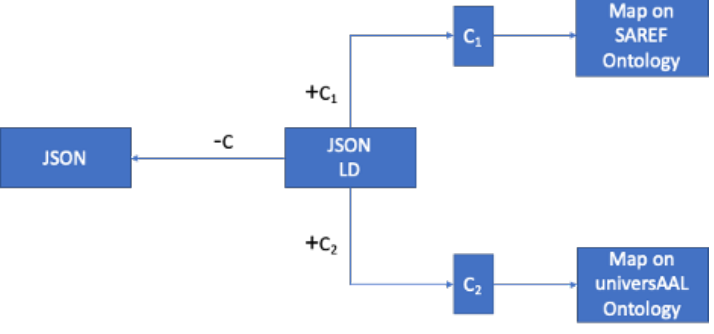
Figure 7. JSON-LD contexts mapping into context C1 and context C2.